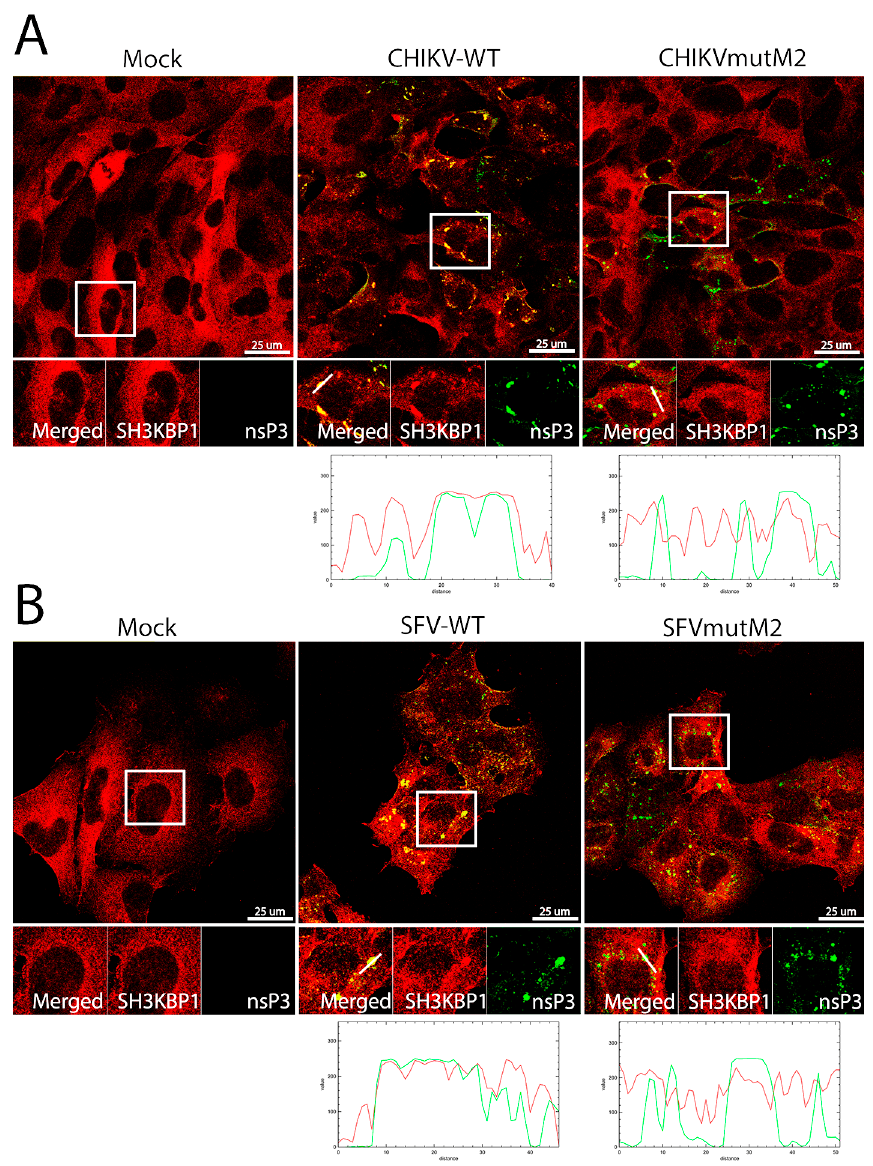
Figure 8. SH3KBP1 co-localises with wt CHIKV and SFV nsP3 protein. HOS cells were infected with CHIKV wt or CHIKVmutM2 ( A ) or SFV wt or SFVmutM2 ( B ) at an MOI of 1. At 16 ( A ) or 8 h pi ( B ), cells were fixed and stained for nsP3 (green) and SH3KBP1 (red) and line scan images are given. Results are representative of two independent experiments.